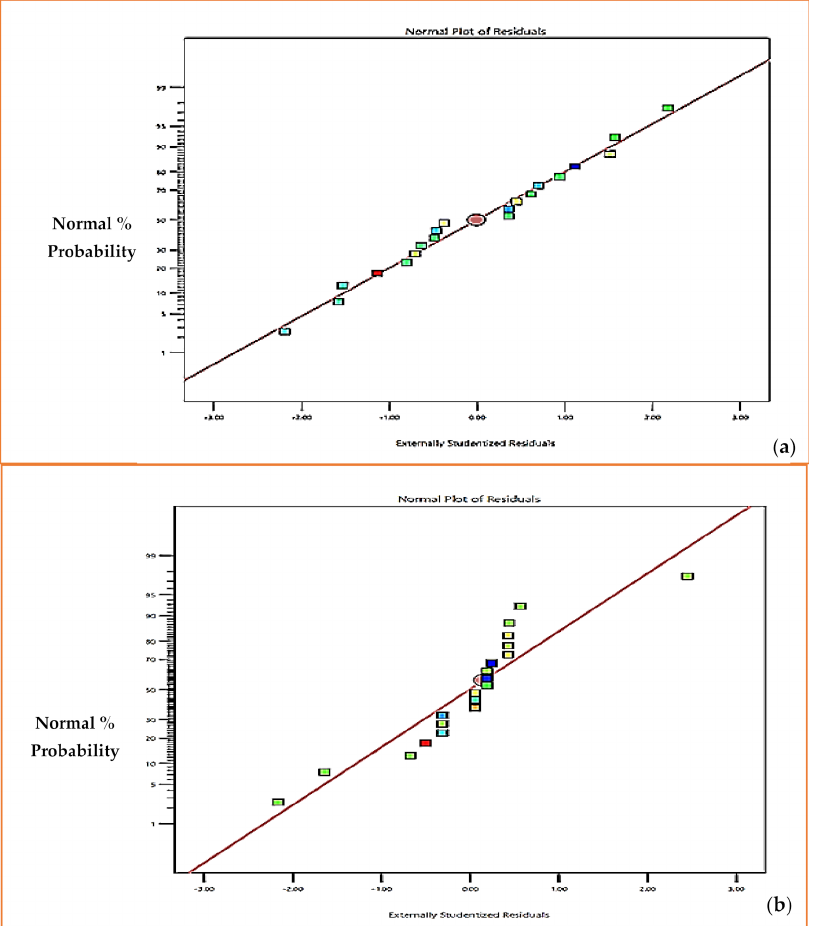
Figure 5. Normality Plot for ( a ) MRR ( b ) SR